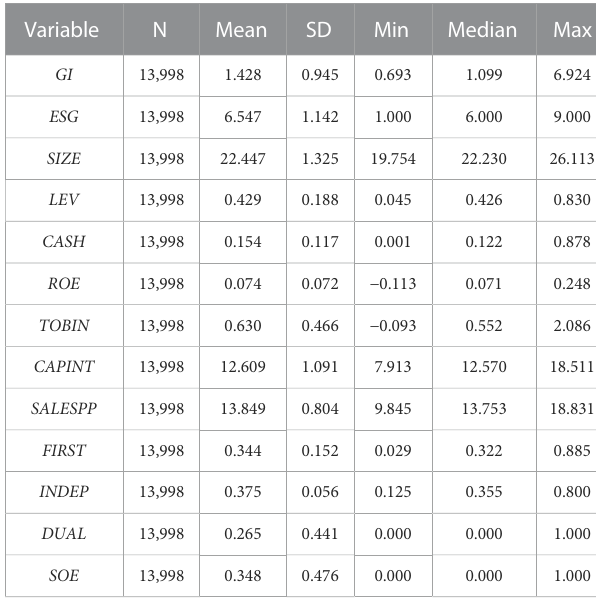
TABLE 1 Summary